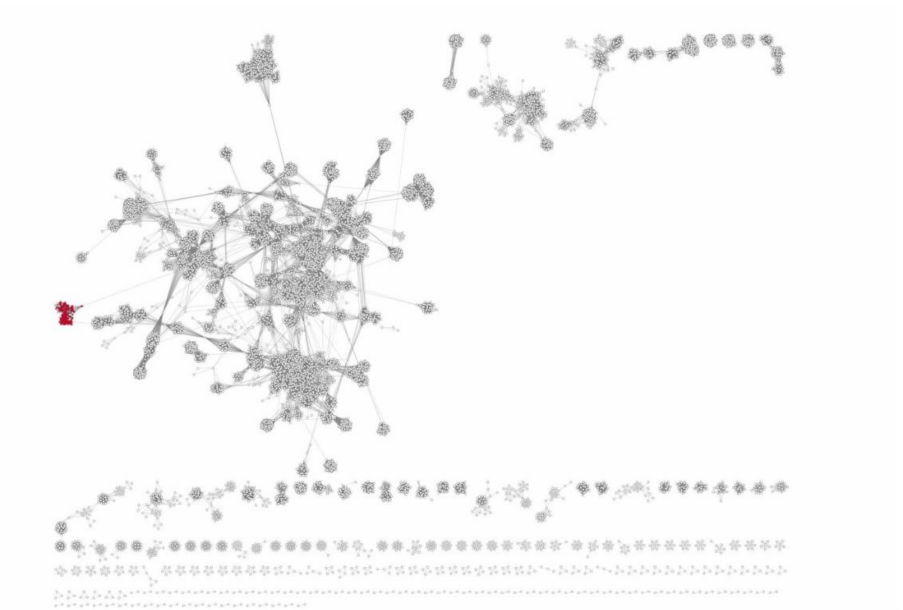
Figure 3. VConTACT2 network analysis. Members of the proposed “ Schitoviridae ” family are marked in red.